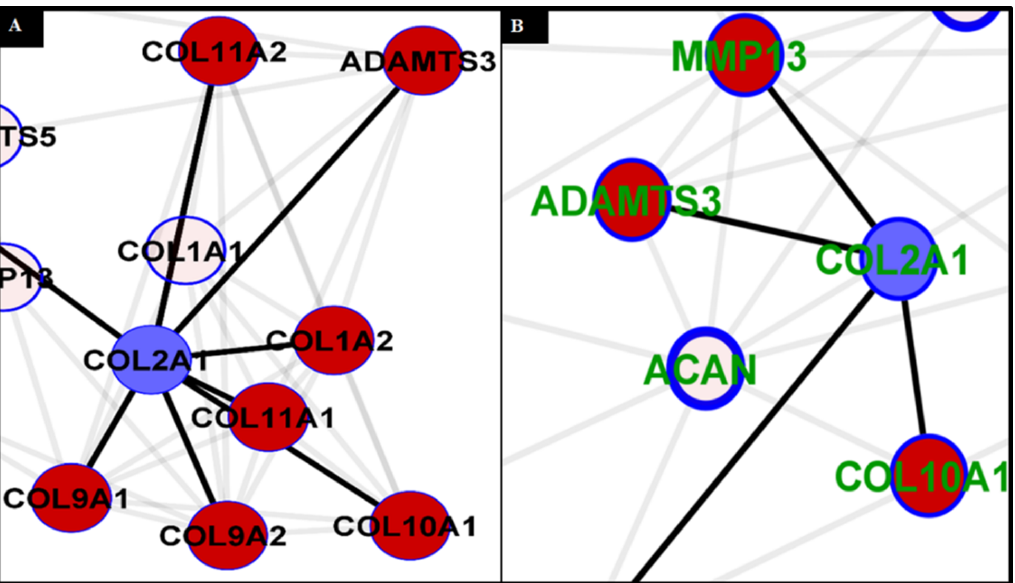
Figure 13. ( A ) String Network of Col2A1, showing the protein’s interaction with other collagen molecules and neighboring molecules in a normal cartilage tissue formation process. Direct interactions are indicated by the red color, whereas neighboring molecules are empty circles. ( B ) String Network of Col2A1, showing the protein’s interaction with other collagen molecules and neighboring molecules in abnormal cartilage formation or cartilage-related disease. Direct interactions are indicated by the red color, whereas neighboring molecules are empty circles. Col2A1-Network (String: PubMed query) created by Cytoscape 3.8.2. and data imported from the curated public databases with the target species being Homo sapiens only.